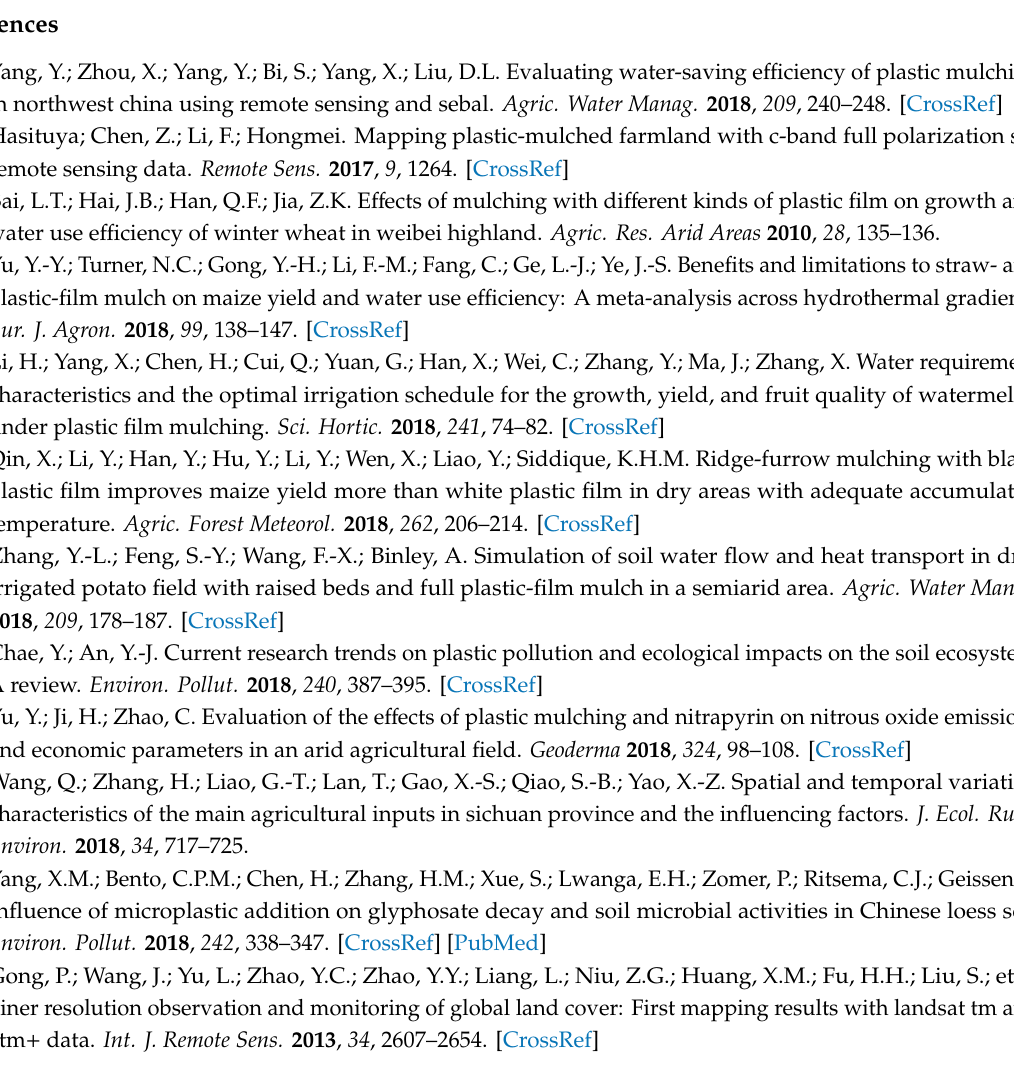
Table S1: Number of Sentinel-2 images acquired for each 15-day period for both study